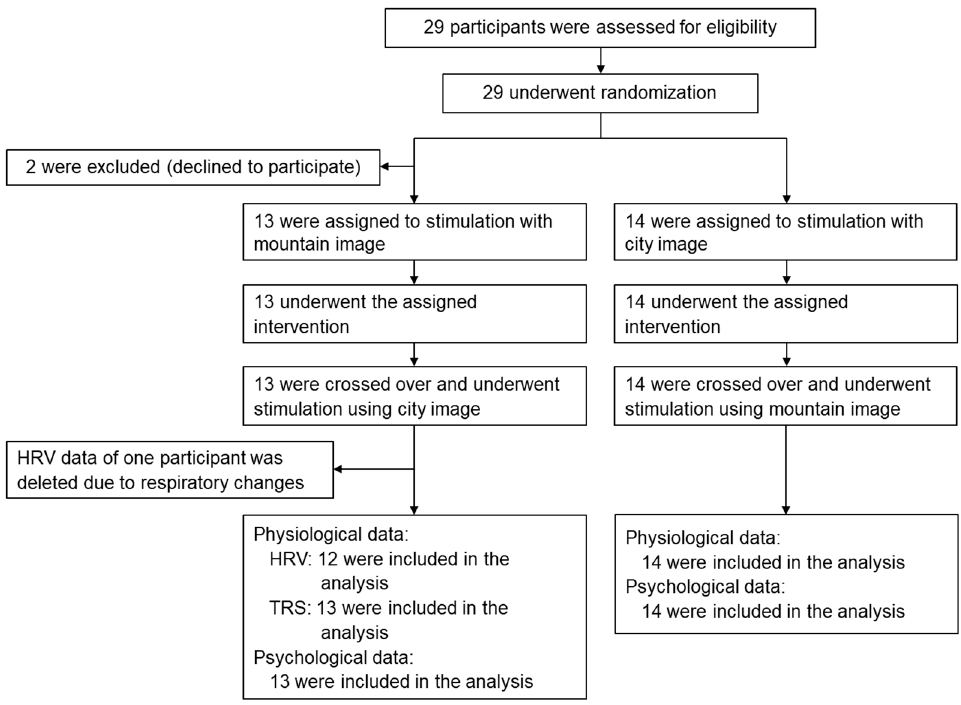
Figure 1. Flowchart of the experiment based on the CONSORT statement. Participant screening, enrollment, follow-up, and analysis flow. HRV (heart rate variability), TRS (near-infrared time-resolved spectroscopy).